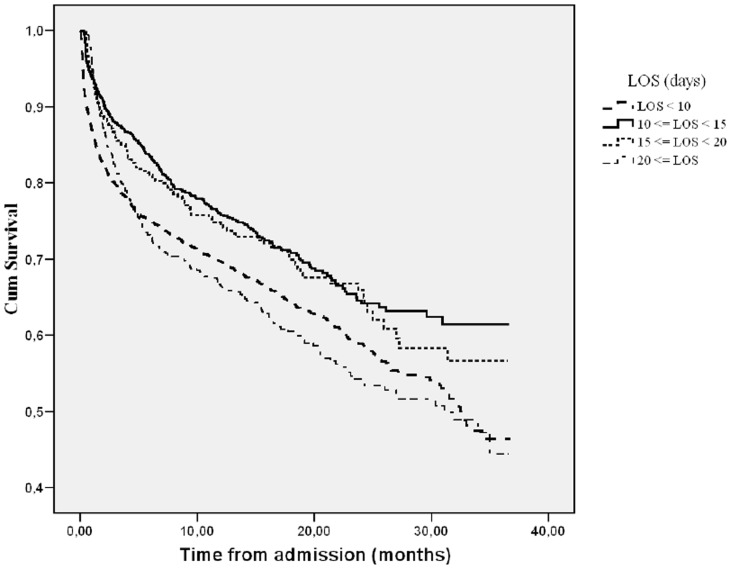
Survival function for ‘Length of Hospital Stay’ (LOS).